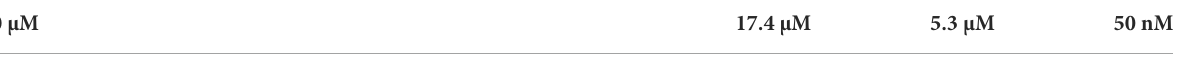
TABLE 2 Binding af fi nity ranges of fl avonoids with Cu(II).